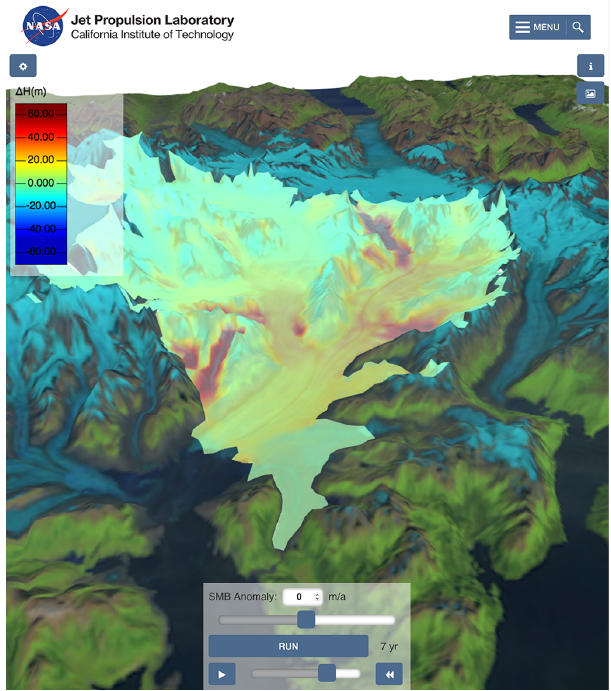
Figure 4. Greenland ISSM simulation on the VESL (https://vesl. jpl.nasa.gov). This particular simulation allows for the introduction of user-driven friction anomalies (using a slider ranging from 5 to 100%) on the steady-state stress-balance velocities for the entire Greenland Ice Sheet. The computations (upon clicking of the RUN button) are carried out on the ISSM computational server (where the model inputs are uploaded and from which the results are down- loaded locally to the client’s web browser). The steady-state veloc- ities are displayed for each value of the friction coefficient that the user chooses. The interactive rendering of the velocity field is done in 3-D using the ISSM WebGL rendering engine. The results are overlaid on a semitransparent topographical rendering of ETOPO5 data (see National Geophysical Data Center (1988) for credits) and a background geotiff image from the Blue Marble: Land Surface, Shallow Water and Shaded Topography project (see Goddard Space Flight Center, Reto Stöckli (2002) for